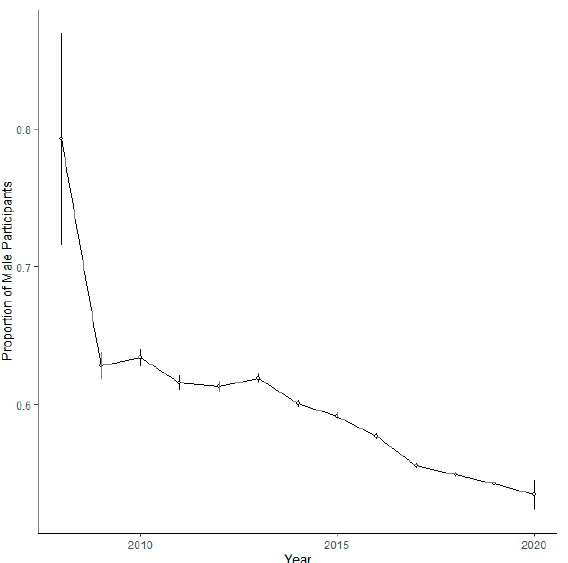
Figure 4. The proportion of male runners by year at Scottish parkrun events. Error bars represent 95% confidence intervals.